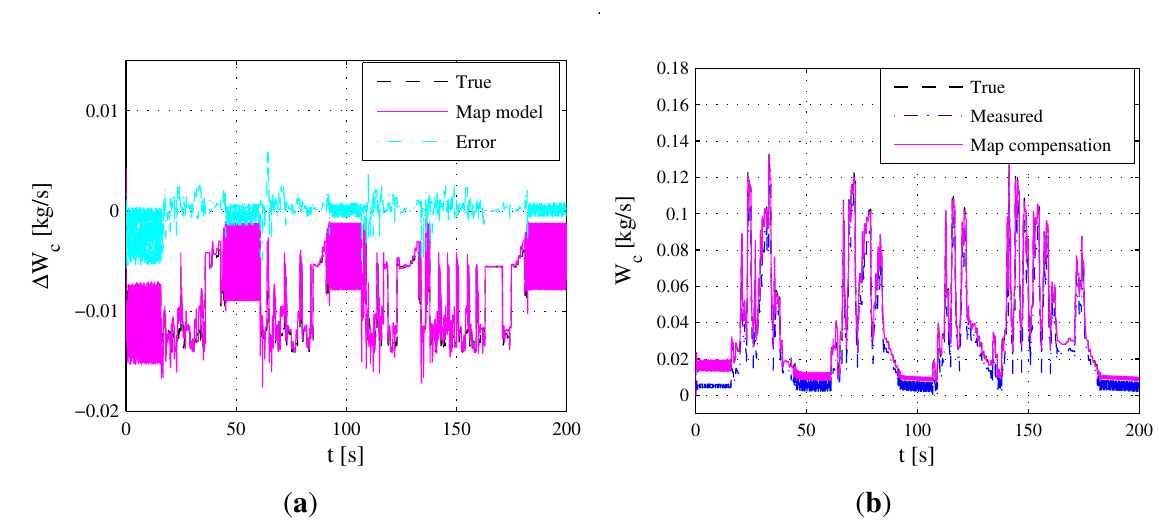
Figure 5. The estimated 2D map for the MAF sensor error. ( a ) Estimation results of the 2D map under ETC Part 1; ( b ) Extrapolation results based on the estimated 2D map.